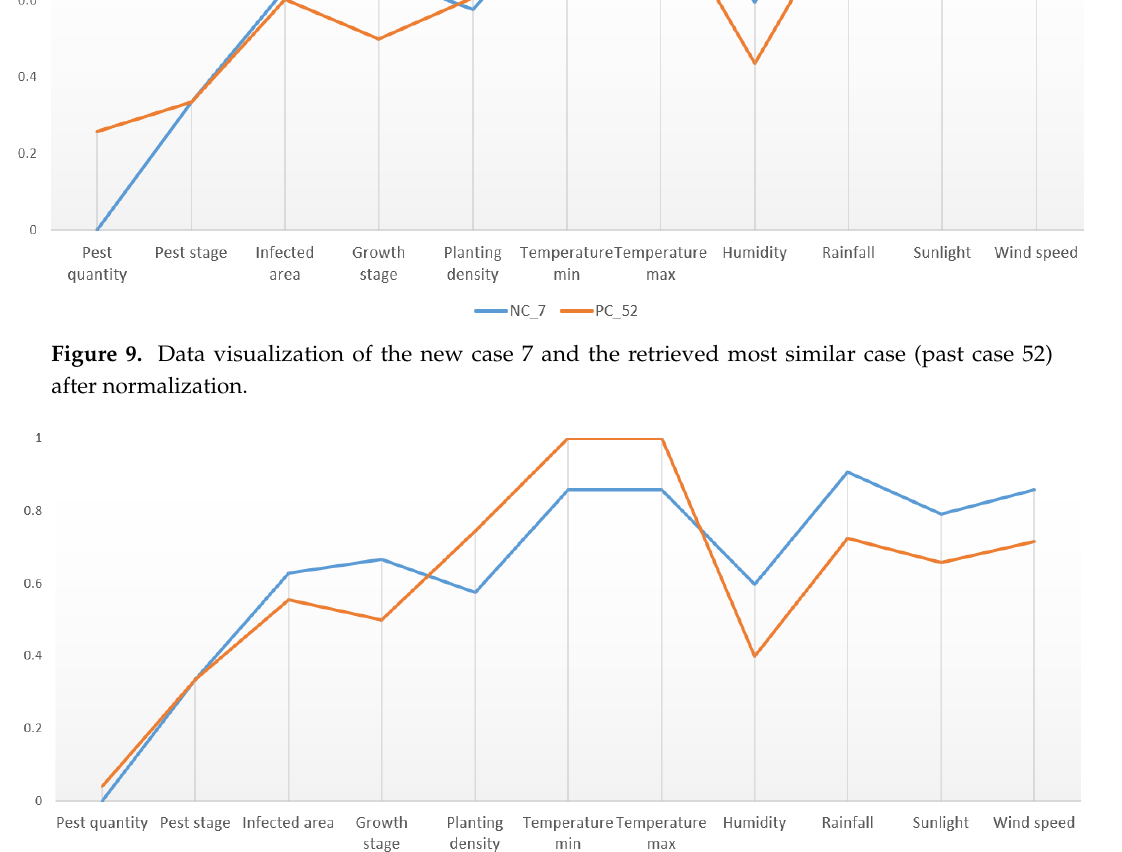
Figure 11. Data visualization of the new case 7 and the retrieved most similar case (past case 646) after normalization. Table 8. Statistical analysis of the new case 7 and retrieved top three similar past cases. Cases